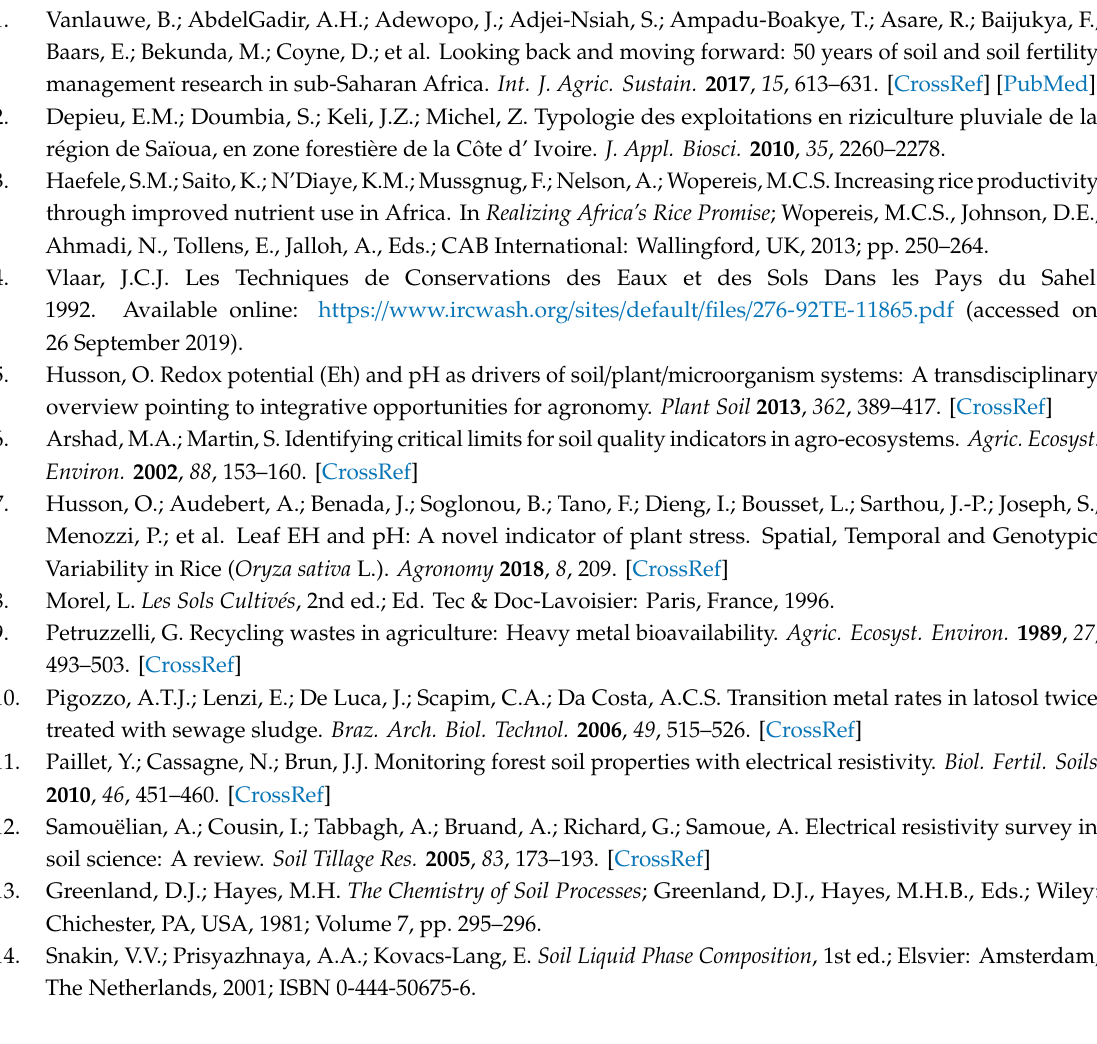
Figure S1. Spatial variability of: soil pH (S1.1), soil electrical conductivity (S1.2), soil carbon (S1.3), soil sand and clay (S1.4), Figure S2: Soil temperature at di ff erent soil depths during 2016 and 2017 growing seasons. Error bars indicate standard error of means, Figure S3. Relationship between organic carbon and humidity according to: upland ecologies (S3.1), Fringe ecologies (S3.2) and Lowland ecologies (S3.3), Figure S4. Relationship between pH and Eh according to: upland ecologies (S4.1), fringe ecologies (S4.2), lowland ecologies